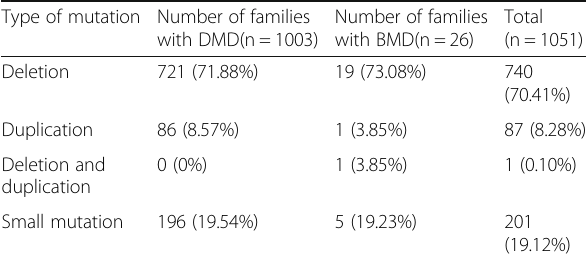
Table 1 Frequency of different DMD mutations in 1051 families with DMD/BMD Type of mutation Number of families Number of families with DMD(n = 1003) with BMD(n = 26)